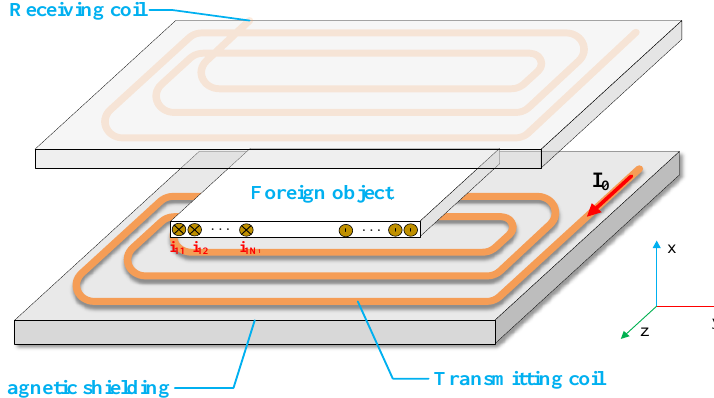
Figure 1. Equivalent model of eddy current in non-ferromagnetic object.